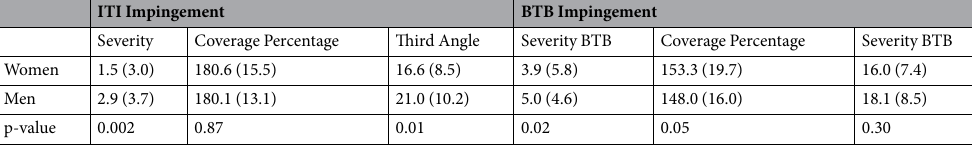
Table 2. Sex specific differences in ITI and BTB